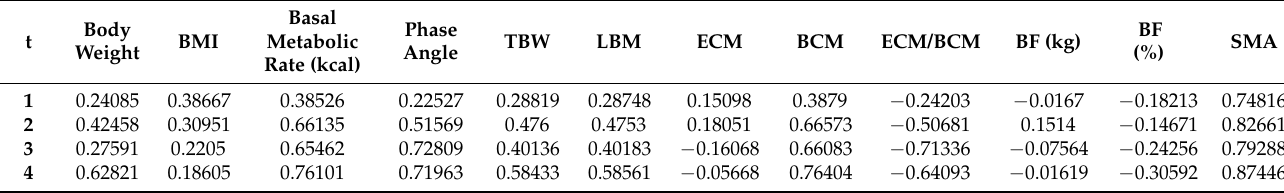
Table 4. Correlation of SMI with BIA parameters.